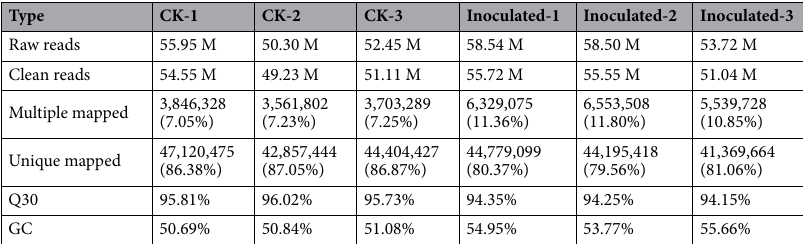
Table 1. Transcriptome analysis of RNA-Seq data. CK stands for mock and Inoculated stands for T. controversa inoculated plants. Numbers represent replication of cDNA libraries generated for respective samples.